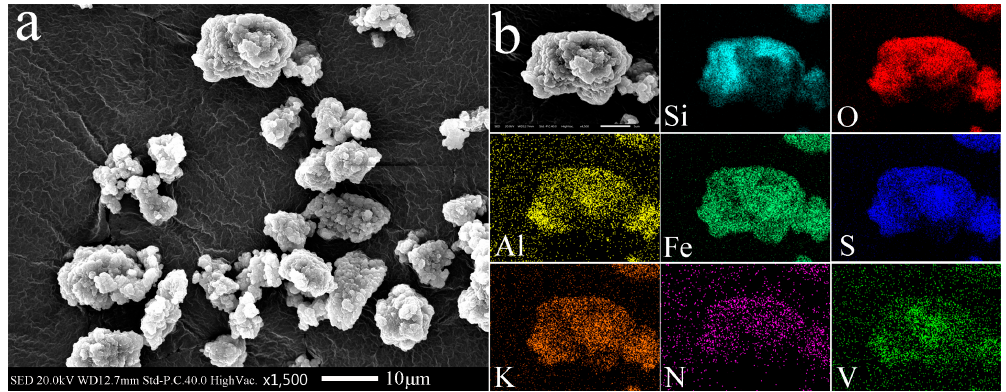
Figure 9. SEM images ( a ) and EDS element mapping ( b ) of leached residues.